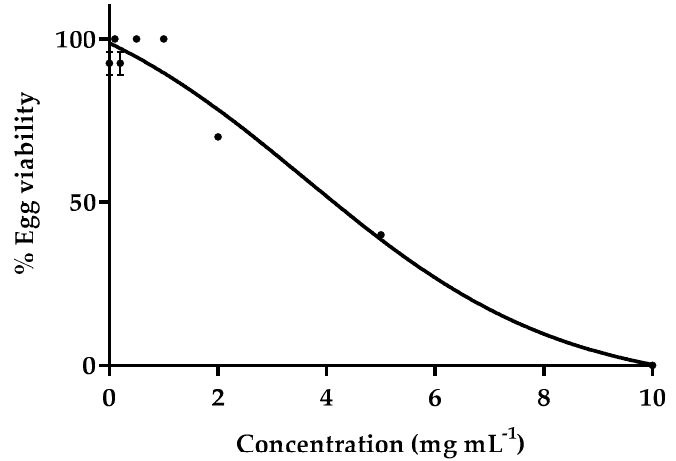
Figure 1. The embryotoxic e ff ect expressed as % egg viability of various concentrations of Andean blueberry in the range 0.1–10 mg mL − 1 . Aquarium water was used for 100% egg viability. Results are mean values ( n = 3) ± standard deviation.